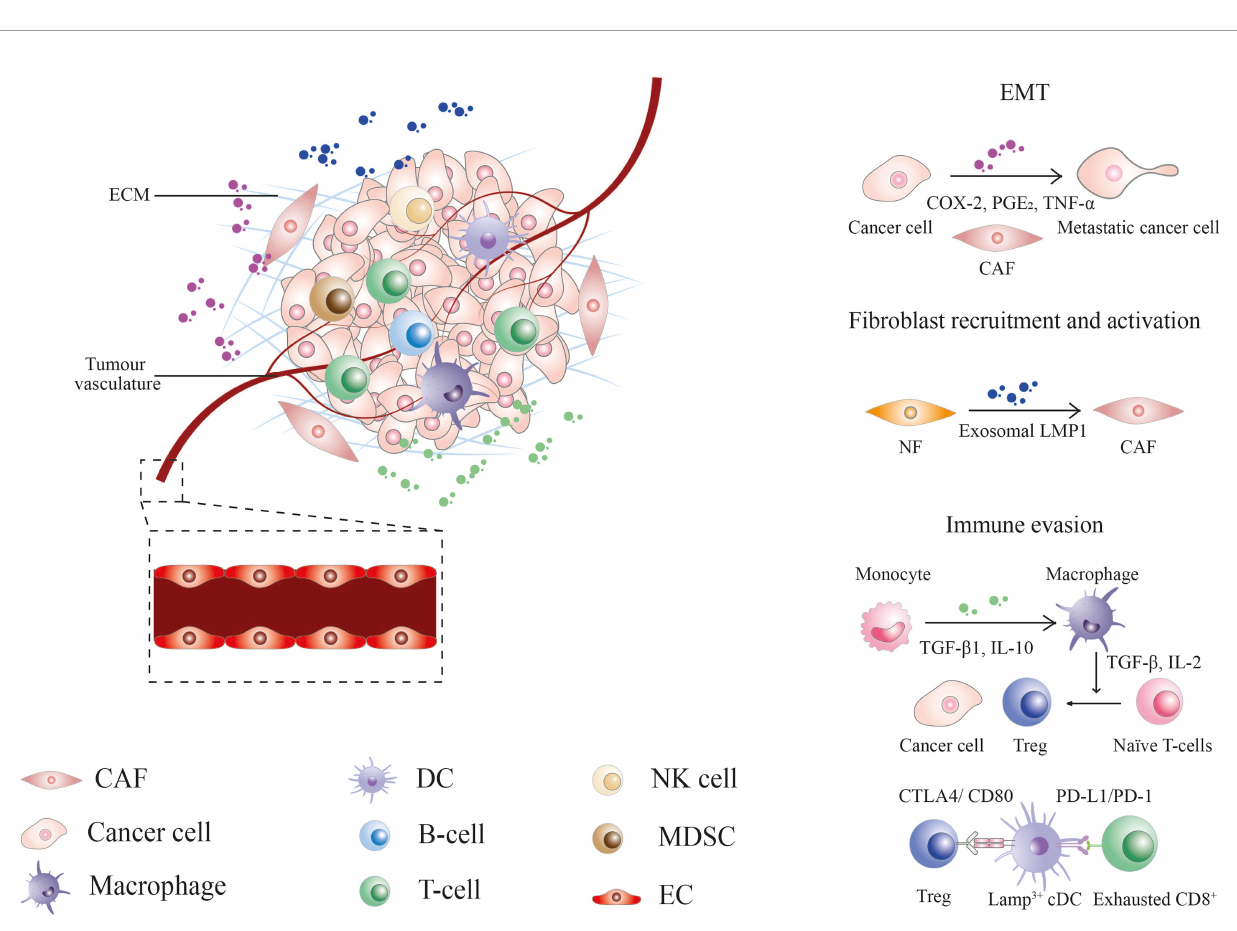
FIGURE 2 | The nasopharyngeal carcinoma tumor microenvironment. CAF, cancer-associated fi broblast; COX-2, cyclooxygenase-2; CTLA4, cytotoxic T- lymphocyte associated protein 4; DC, dendritic cell; EC, endothelial cell; ECM, extracellular matrix; EMT, epithelial-mesenchymal transition; Exo-LMP, exosome- packaged latent membrane protein; IL, interleukin; MDSCs, myeloid-derived suppressor cells; NF, normal fi broblast; NK, natural killer; PD-1, programmed cell death protein 1; PD-L1, programmed death-ligand 1; PGE 2 , prostaglandin E2; TGF, tumor growth factor; TNF, tumor necrosis factor; Treg, regulatory